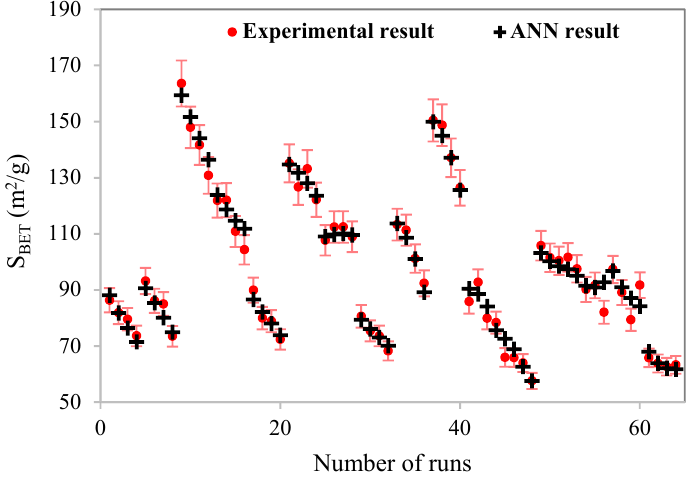
Figure 5. Comparison of the normalized experimental and ANN predicted data for different data sets: training, validation, test, and all data sets.